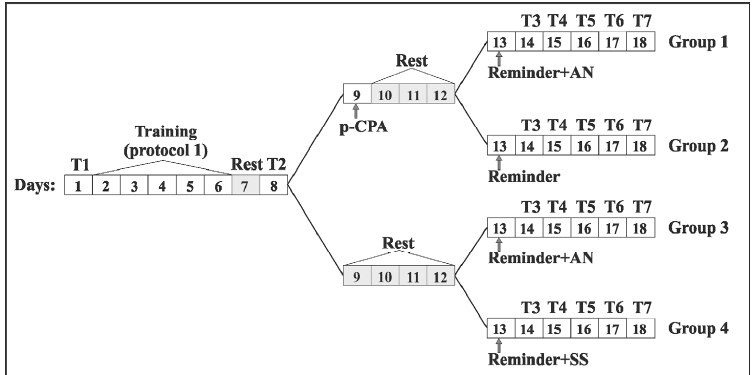
Figure 1. Scheme of the experimental series 1 (protocol 1) and series 2 (protocol 2; Groups 1/5, 2/6,